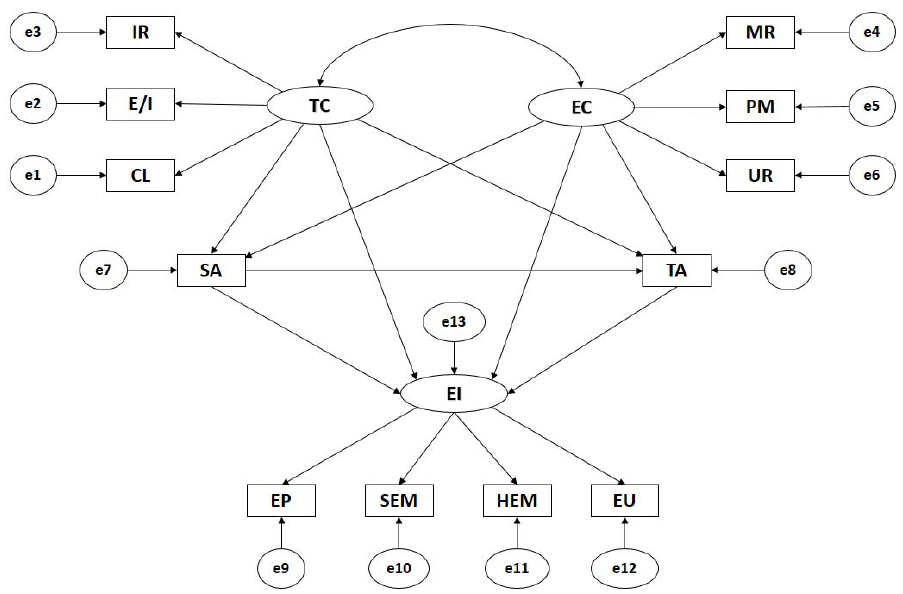
Figure 1. Theoretical Model. Note: TC, Task Climate; CL, Cooperative Learning; E/I, Effort/Improvement; IR, Important Role; EC, Ego Climate; MR, Member Rivalry; PM, Punishment for Mistakes; UR, Unequal Recognition; SA, State Anxiety; TA, Trait Anxiety; EI, Emotional Intelligence; HEM, Heteroemotional Management; SEM, Self ‐ emotional management; EP, Emotion Perception; EU, Emotion Utilisation.